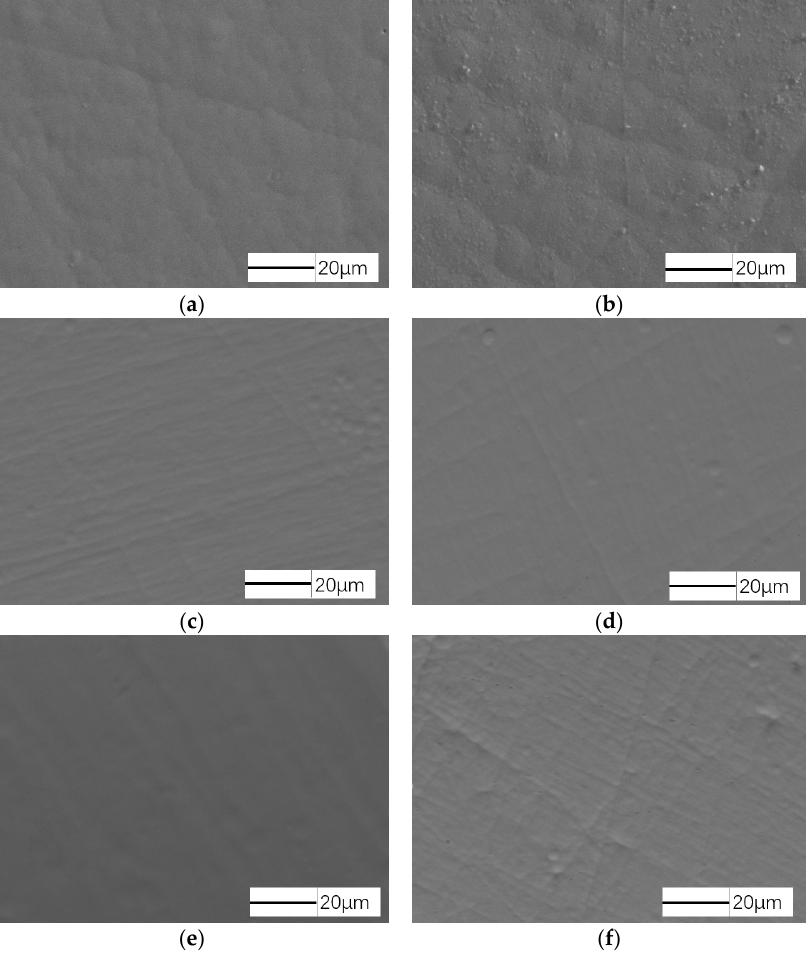
Figure 1. Micromorphology of coatings deposited under different currents. ( a ) DC as deposited; ( b ) DC 400 °C heat treated; ( c ) SP as deposited; ( d ) SP 400 °C heat treated; ( e ) DP as deposited; ( f ) DP 400 °C heat treated.